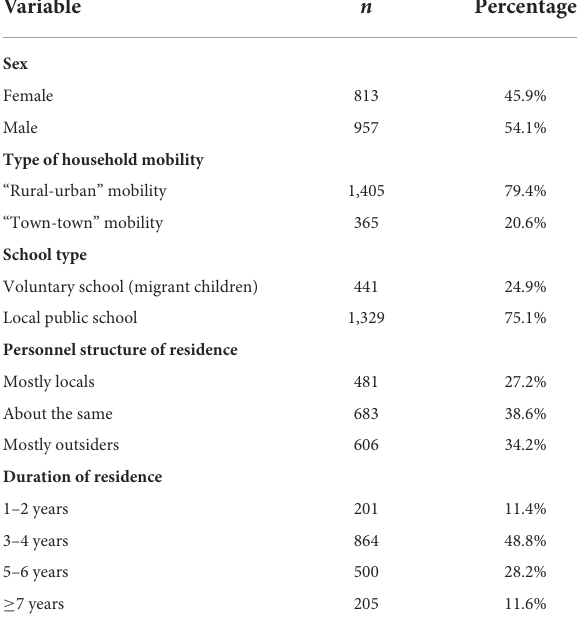
TABLE 1 Demographic characteristics of the